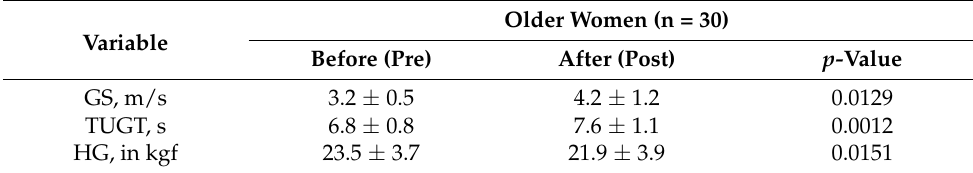
Table 2. Functional physical tests (GS, in meters per seconds (m/s); and TUGT, in seconds (s)) and muscle strength measure (HG, in kilograms of force (kgf)), presented as mean and standard deviation (SD), of older women volunteers participating in the study.